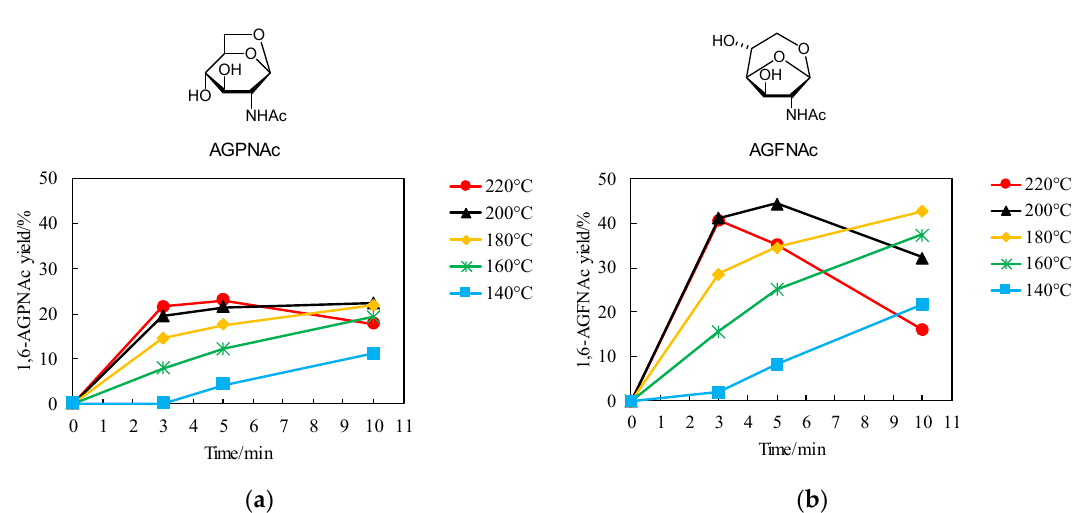
Figure 2. The plots of the yields of ( a ) AGPNAc and ( b ) AGFNAc as a function of the reaction time. The yields of AGFNAc have been similarly determined by the area integrations for the peak at RT = 18.9 min for the HPLC measurements and plotted in Figure 2b. The 140, 160, and 180 °C systems